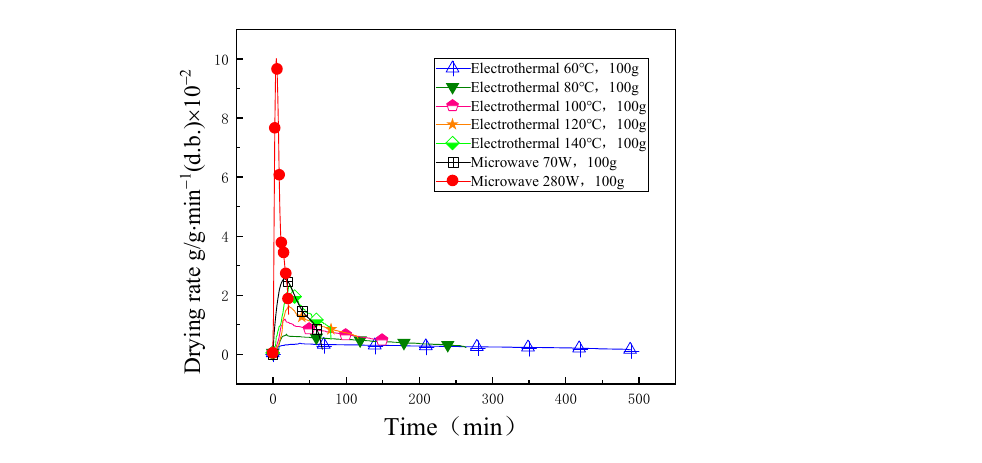
Figure 9. Comparison of drying rate between microwave drying and electrothermal drying.